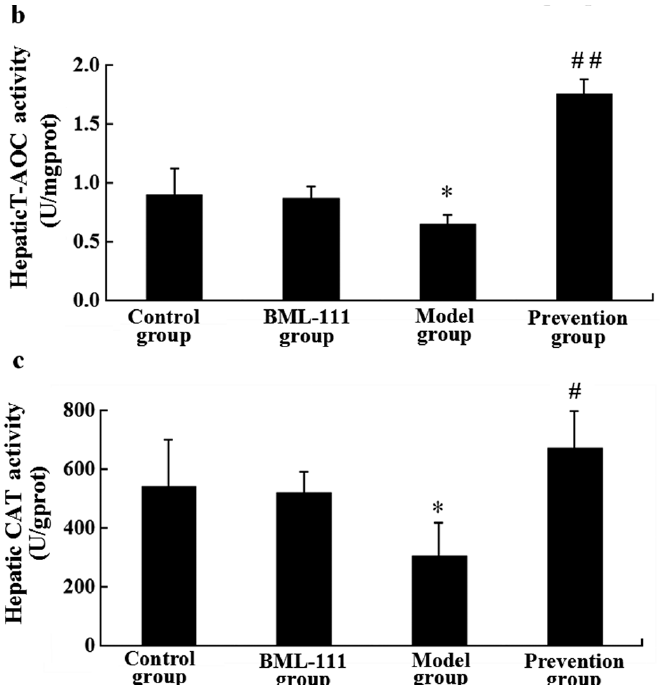
Figure 8. BML-111 improved hepatic antioxidant capacity. ( a ) Superoxide dismutase (SOD) and hydroxyl radical-scavenging ability were evaluated using assay kits; ( b ) Total antioxidant capacity (T-AOC) was examined by assay kit; ( c ) The activities of catalase (CAT) was tested through assay kit at 8 h after being challenged with LPS/ D -GalN. * p < 0.05 compared with the control group, # p < 0.05, ## p < 0.01 compared with model group ( n = 6).